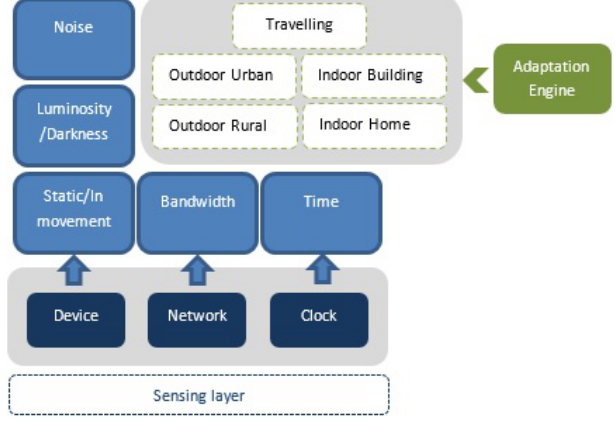
Figure 3. The Physical Model of the AMBLE